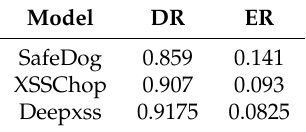
Table 3. Adversarial result. DR, detection rate; ER, escape rate.